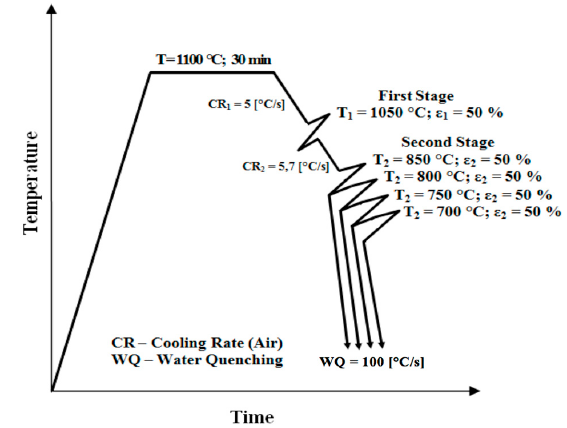
Figure 1. Experimental schedules.